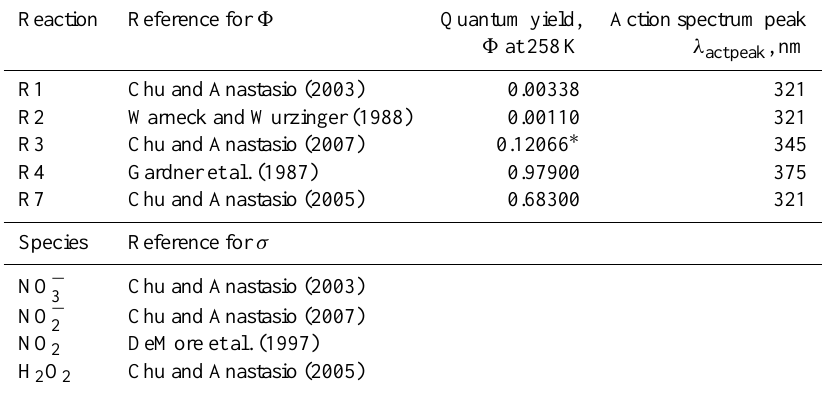
Table 1. Reference for quantum yield, (cid:56) , used for Reactions (R1)–(R4) and (R7) and absorption cross section, σ , of the NO − NO − anion, H 2 O 2 , and NO 2 2